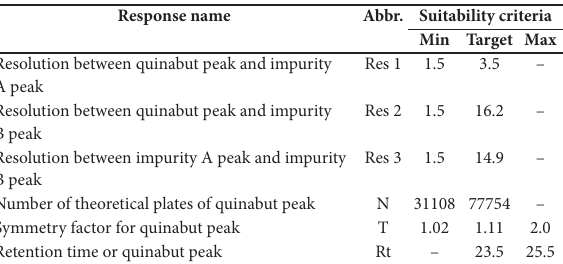
Table 3. Responses and used suitability criteria for method op- timization and sweet spot analysis.